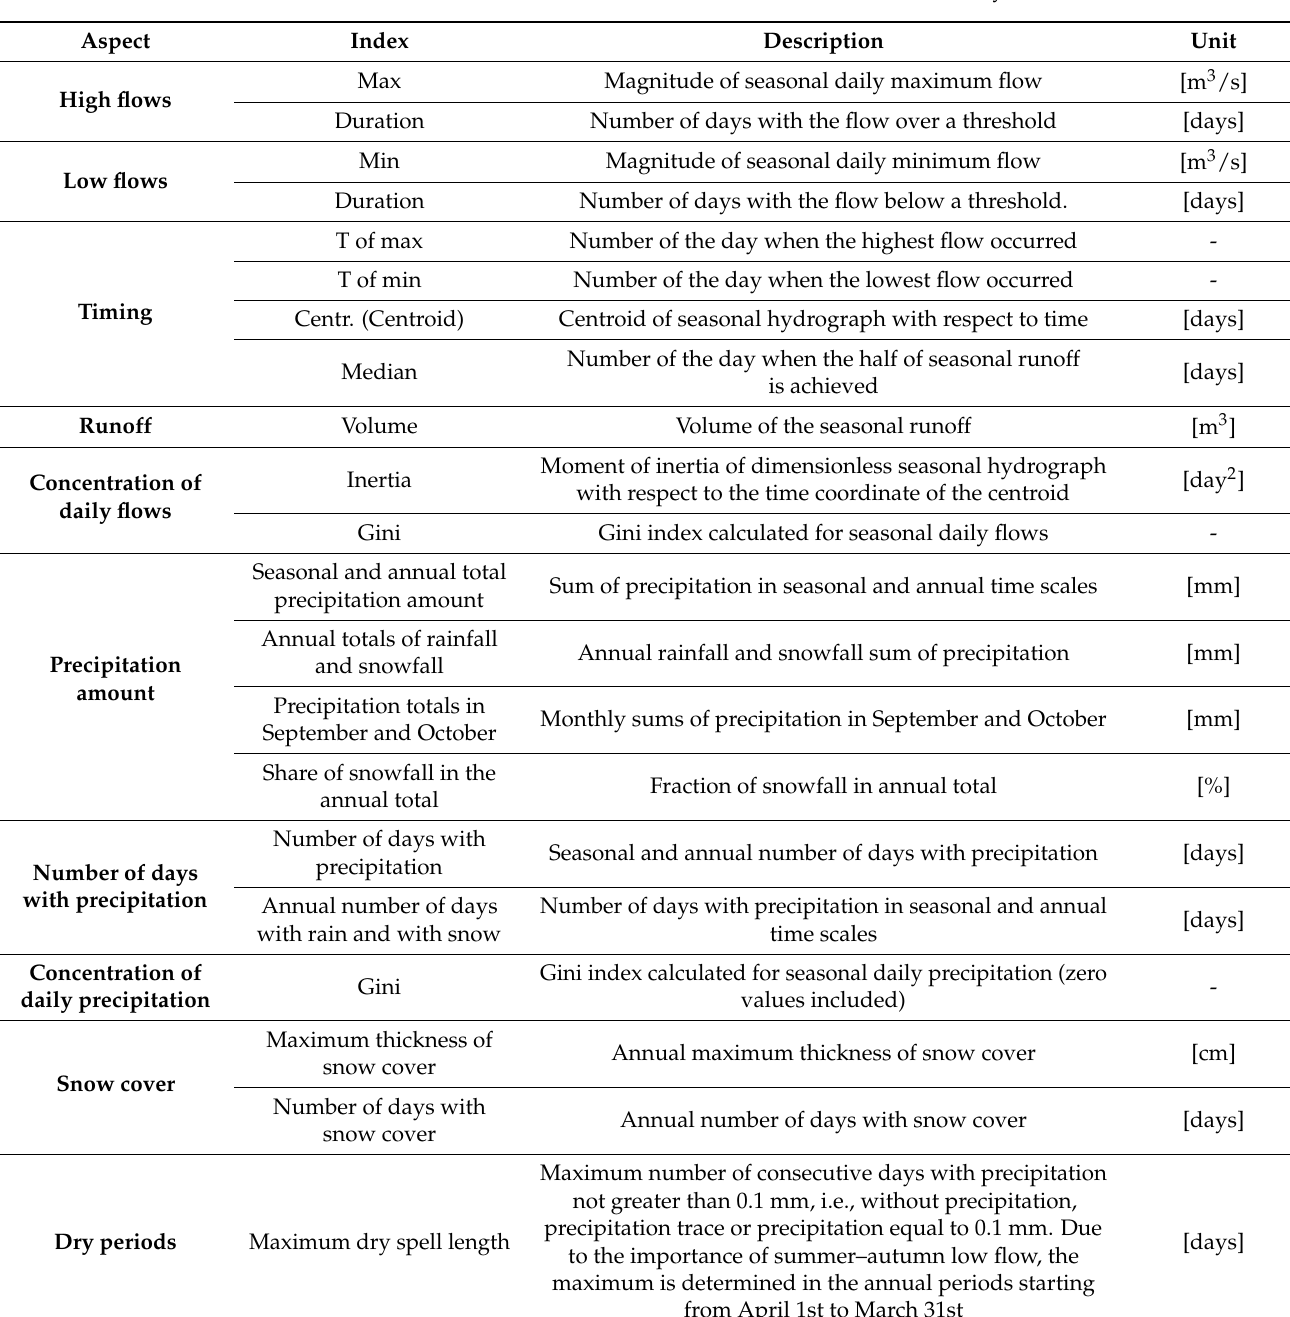
Table 4. The list of statistical measures and indicators used in this